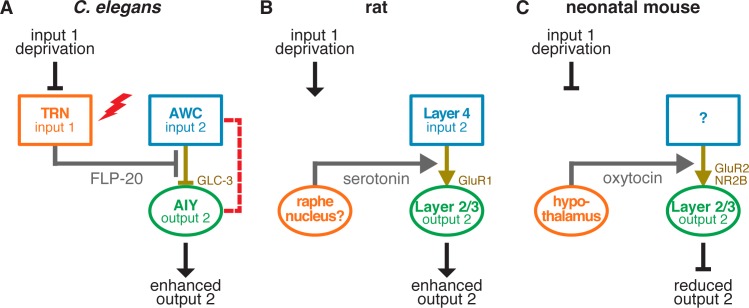
Molecular/cellular mechanisms for cross-modal plasticity following sensory loss.(A) Loss of body touch in C. elegans results in reduced neuropeptide secretion from the TRNs, leading to the release from suppression, i.e., strengthening, of the inhibitory glutamatergic synaptic connection between AWC chemosensory neurons and AIY interneurons and thus enhancing the output of the olfactory circuit. Optogenetic activation of the TRNs (red lightning bolt) or insertion of an engineered electrical synapse between AWC and AIY (red dashed line) can counteract these effects. (B) Visual deprivation in rats results in increased serotonin signaling, possibly from the raphe nucleus, increasing extracellular serotonin abundance in layer 2/3 of the barrel cortex, which in turn strengthens the excitatory glutamatergic synaptic connections between the sensory input layer 4 and the cortical output layer 2/3, thus enhancing somatosensory output [11]. (C) Visual or whisker deprivation in mice results in reduced oxytocin secretion from the hypothalamus, which leads to reduced synaptic transmission to somatosensory or visual cortical output layer 2/3, reducing the output [13]. Rectangles represent sensory or sensory input neurons and ovals represent downstream output neurons.